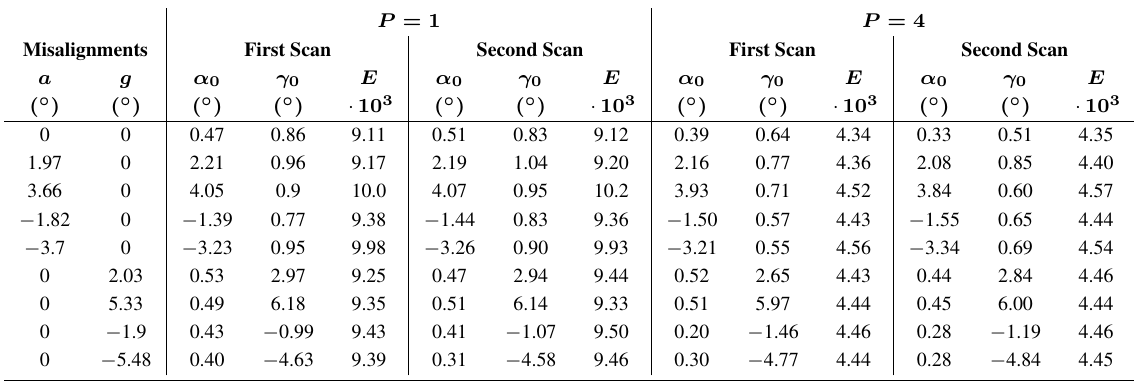
Table 2. Calibrated parameters with and without misalignments for the second unit of UNO-laser.